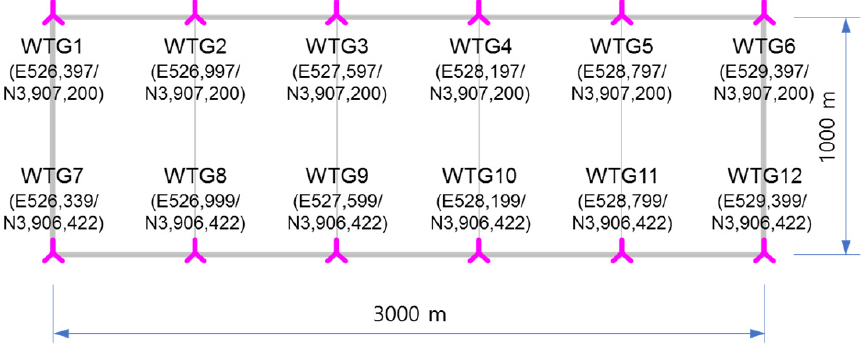
Figure 6. Design variables for offshore wind farm layout based on unrestricted coordinates (scenario 2).